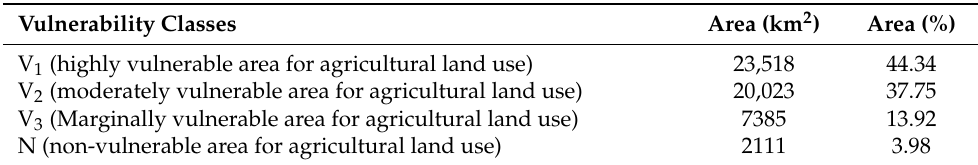
Table 4. Vulnerable area for agricultural land use according to their vulnerability